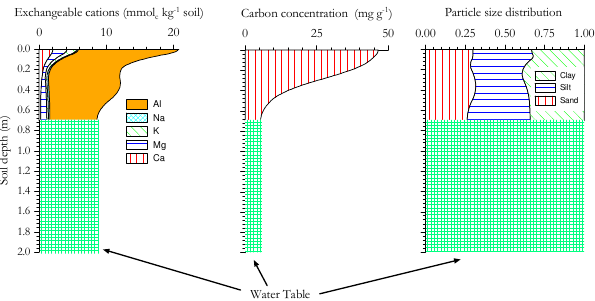
Fig. 17. Profiles of exchangeable cations, soil carbon and texture Fig. 17 for a Endogleyic Umbrisol (Alumic, Hyperdystric) in Bolivia (LSL- 01).